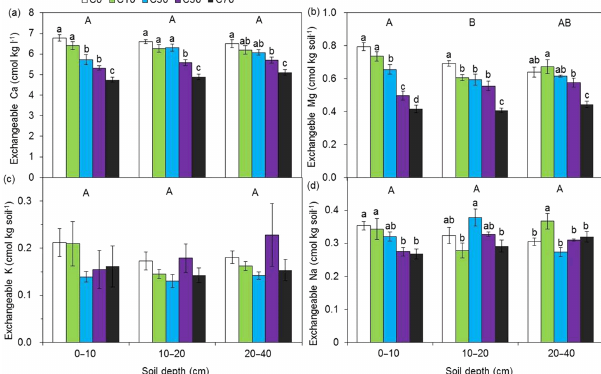
Figure 3. Soil base cations of exchangeable Ca (a) , Mg (b) , K (c) , and Na (d) for three soil depths in different soil coarseness degrees of 0% sand addition (C0), 10% (C10), 30% (C30), 50% (C50), and 70% (C70). Data represent mean ± SE ( n = 6). Letters indicate significant differences among treatments (lowercase letters) and dif- ferences among soil depths when averaging across all treatments (capital letters). Bars without letters above denote no significance is detected among